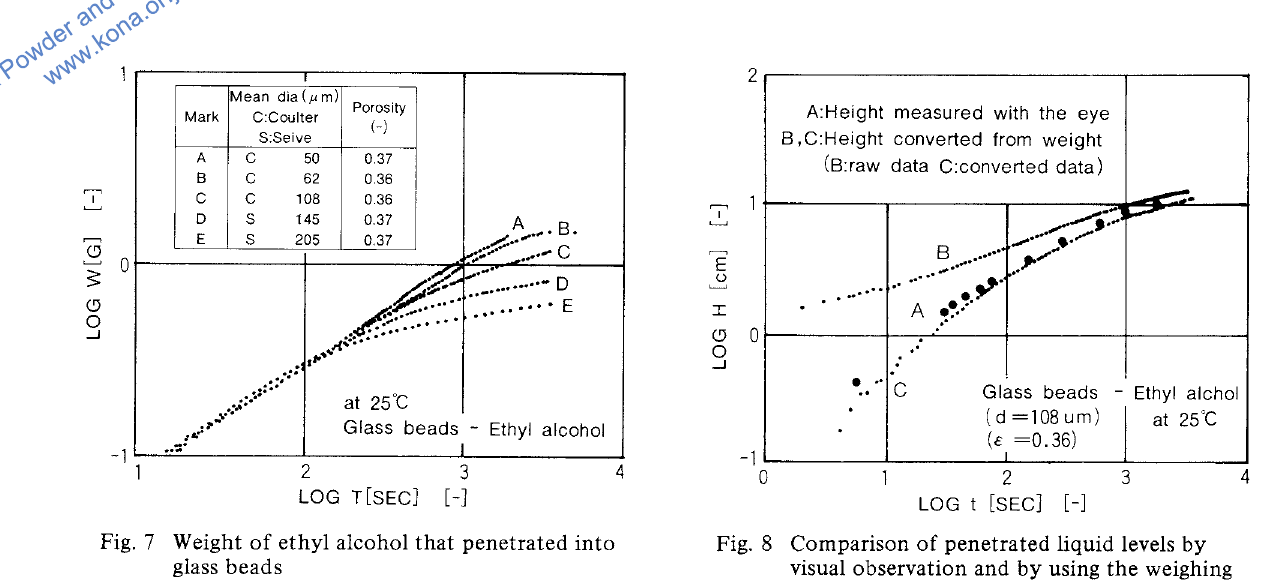
Fig. 7 Weight of ethyl alcohol that penetrated into glass beads